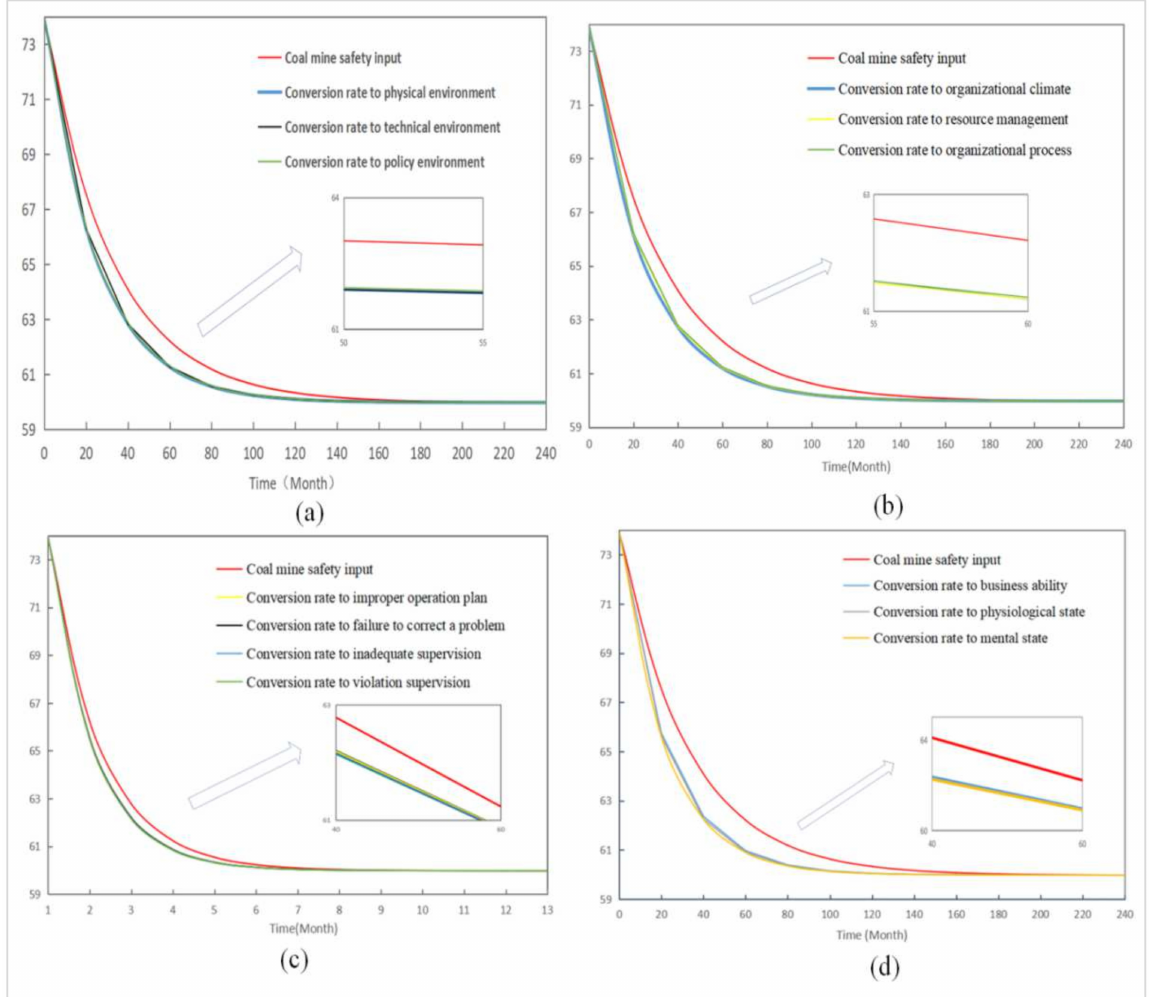
Figure 10. Levels of miners’ unsafe behavior with different conversion rates of risk factors: ( a ) Envi- ronmental factors; ( b ) Organizational influence; ( c ) Unsafe supervision; ( d ) Miners’ unsafe